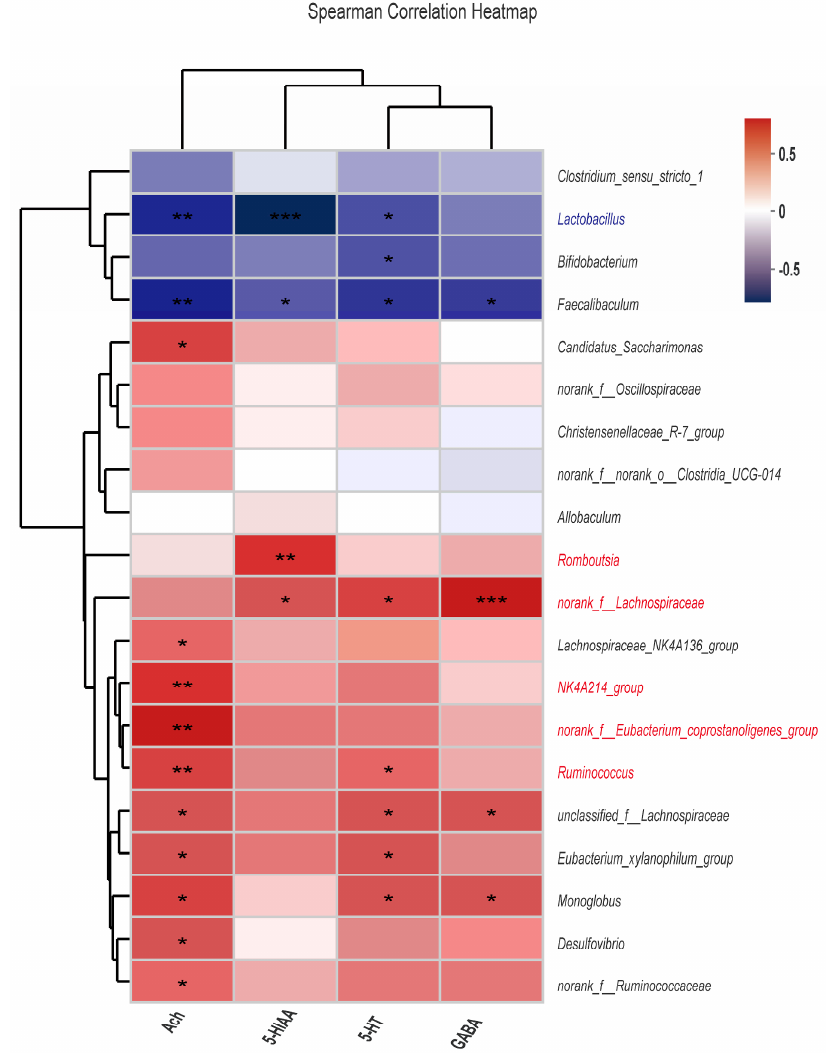
Figure 7. Correlation analysis between gut microbiota and neurotransmitters. (* p < 0.05, ** p < 0.01, *** p < 0.001 indicates a statistically significant difference.)